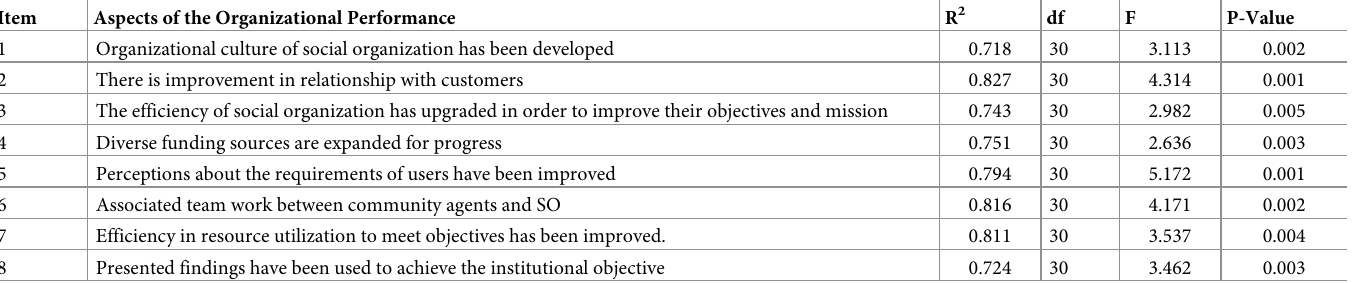
Table 4. Activities of OI and SI explaining percentage variability of organizational